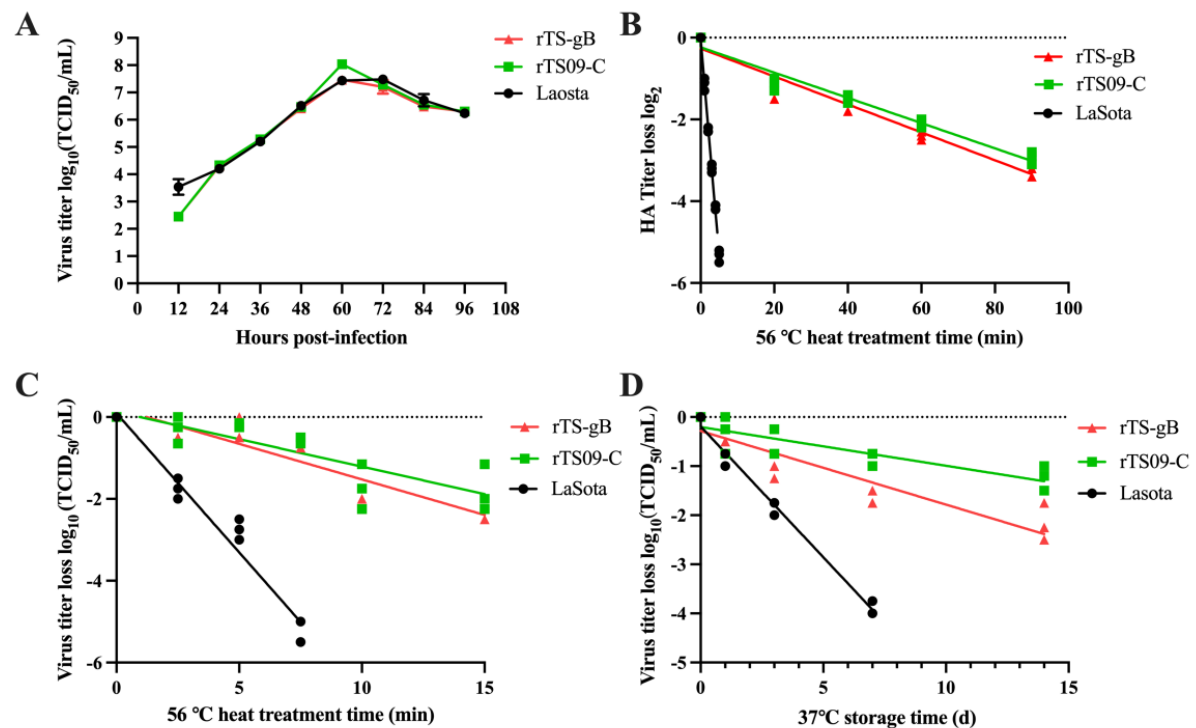
Figure 3. The growth kinetics and thermal properties of rTS-gB. ( A ) BHK-21 cells infected with rNDVs at MOI of 0.1 were harvested at the interval of 12 h, and the viral titers of cultured supernatants were determined using the TCID 50 assay. After heat treatment at 56 ◦ C, the HA titer ( B ) and viral titer ( C ) of heat-treated virus were determined by the HA assay and TCID 50 assay. ( D ) At 37 ◦ C preservation, the recombinant NDVs harvested at different time points were titrated using the TCID 50 assay. The stability of rTS-gB was further assessed stored at 37 ◦ C. Allantoic fluids con- taining rTS-gB, rTS09-C, and LaSota were stored at 37 ◦ C from 1 to 14 days, and the residual titer of the virus at the indicated time points was determined in BHK-21